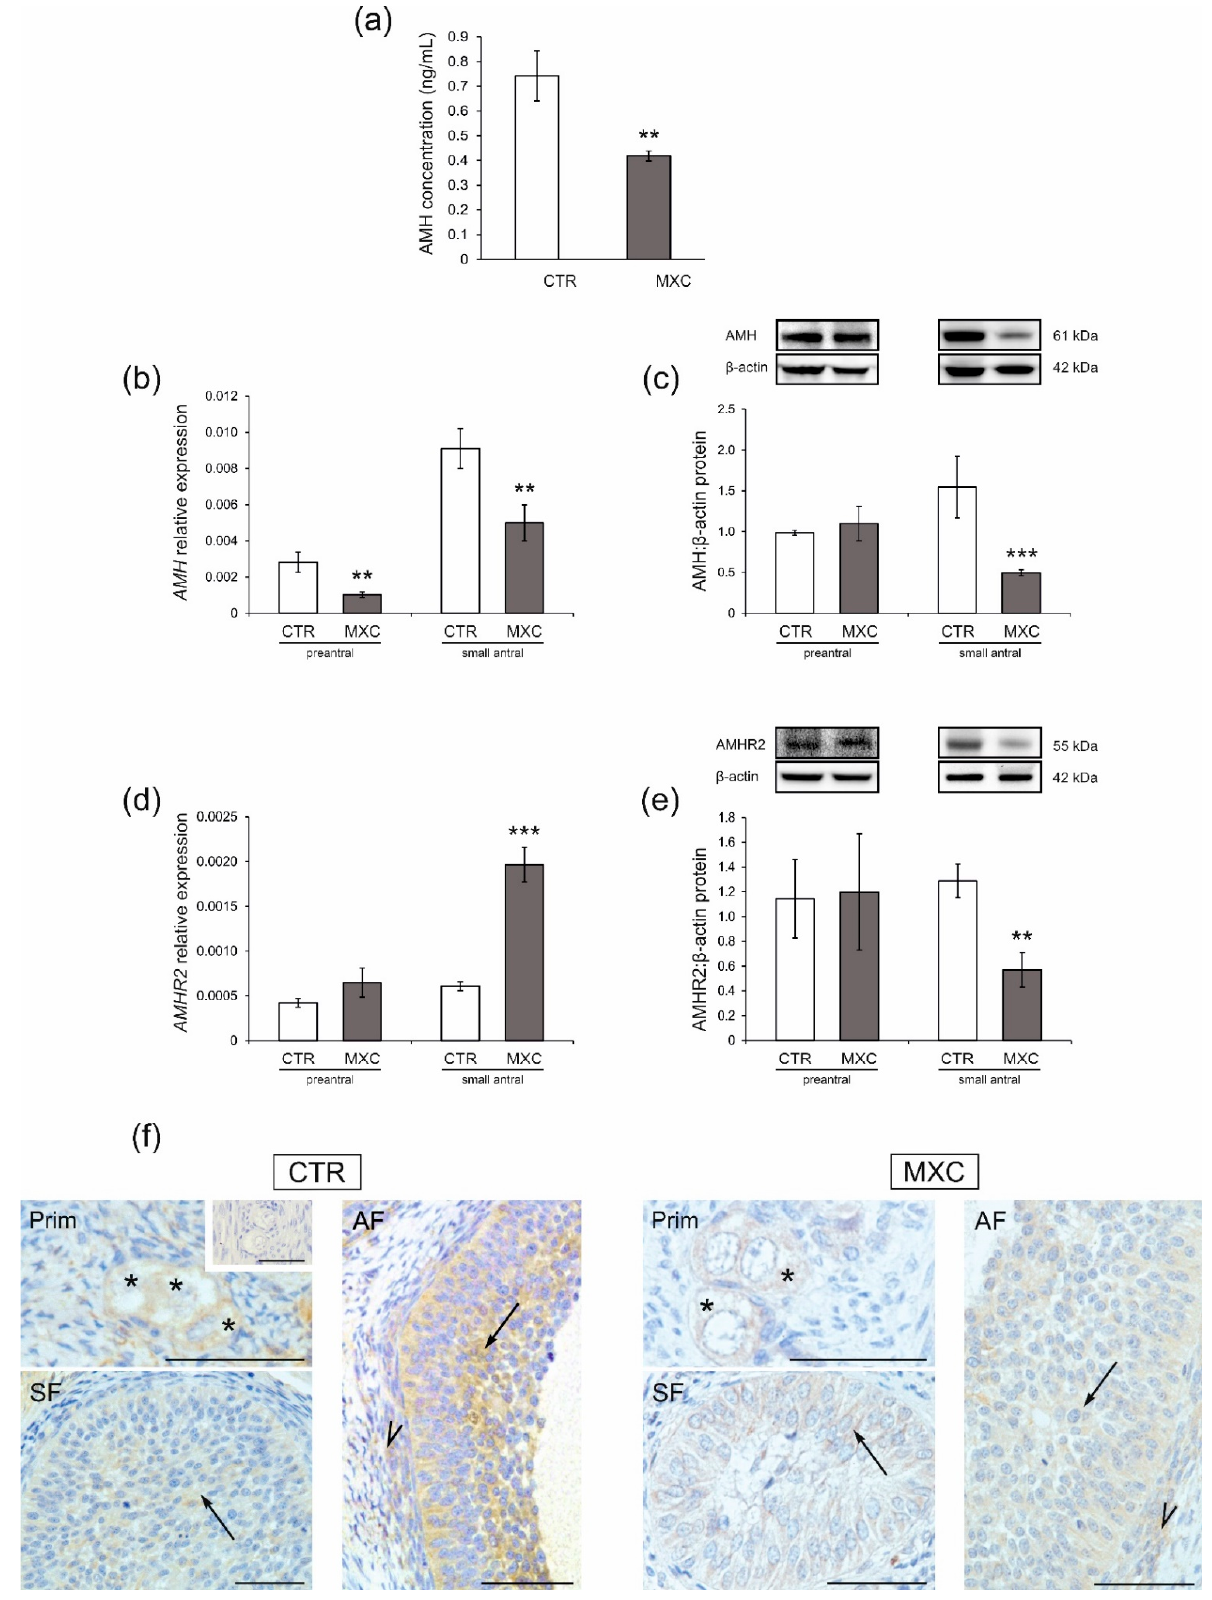
Figure 4. Plasma anti-Müllerian hormone (AMH) concentration in the control (CTR) and methox- ychlor (MXC-) treated adult pigs ( a ) ( n = 5 per each group). AMH ( b , c ) and AMHR2 ( d , e ) mRNA